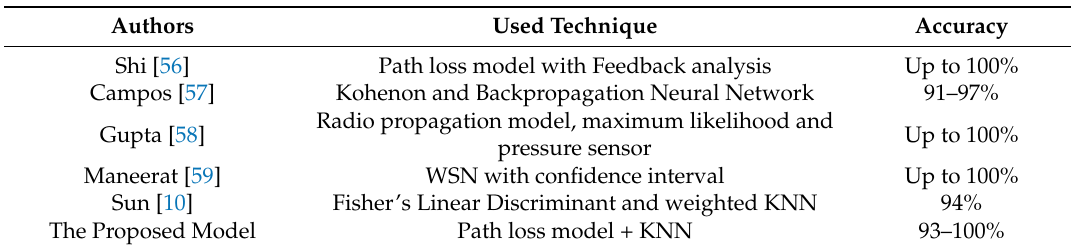
Table 1. Related work floor positioning techniques and accuracy rate.